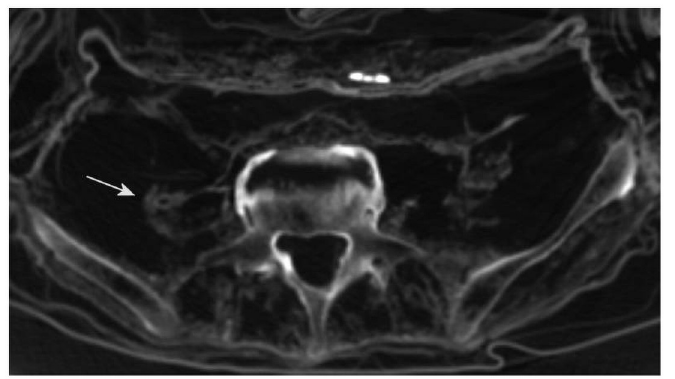
Fig 6. CT scan of a retroperitoneal mass on the right side